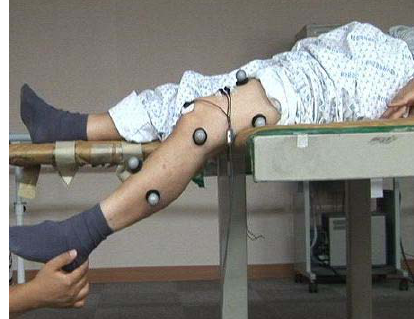
Fig.1. Positioning of the participant and placement of EMG electrodes and